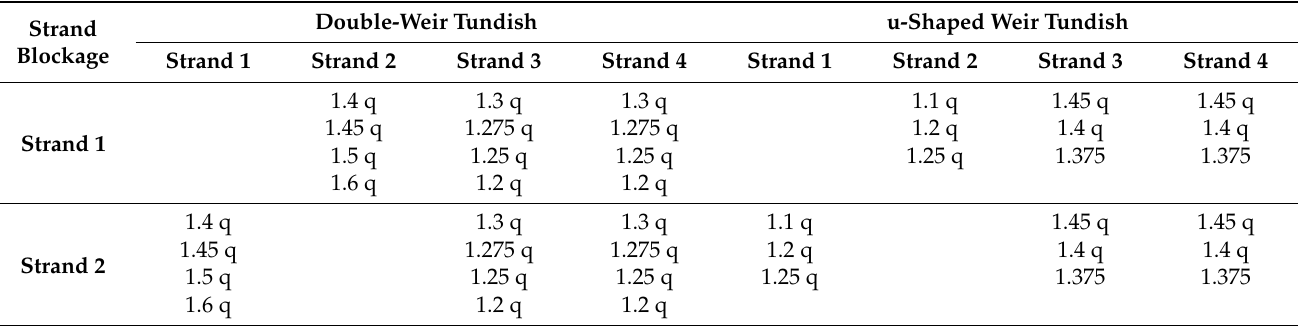
Table 5. Studied cases of non-uniform increasing casting flow